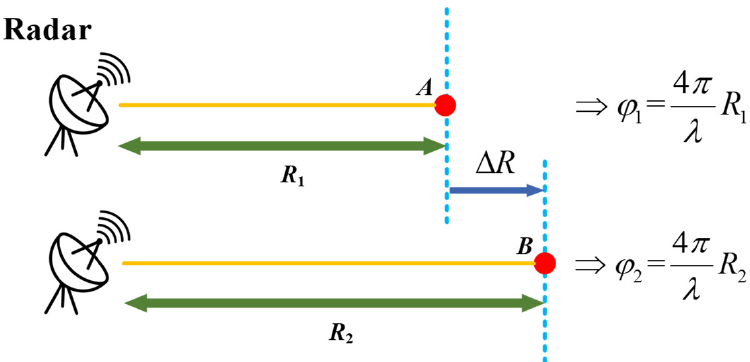
Figure 1. Diagram of deformation measurement.